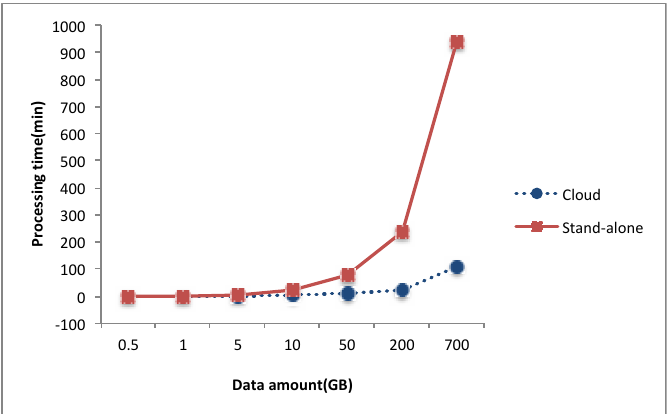
Figure 3. Runtime required to obtain the vegetable drought monitoring products versus stand-alone (4 cores) with increasing data volumes.